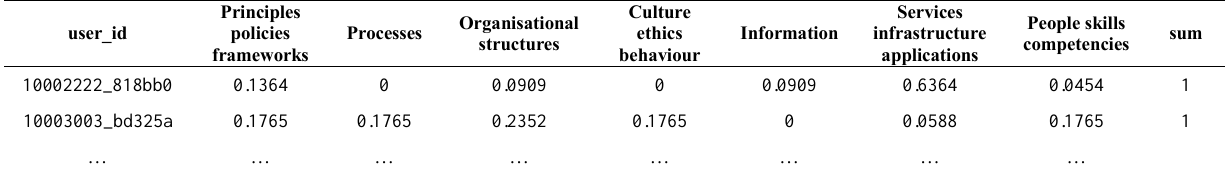
Table 2. Example of assigned and normalised characteristics